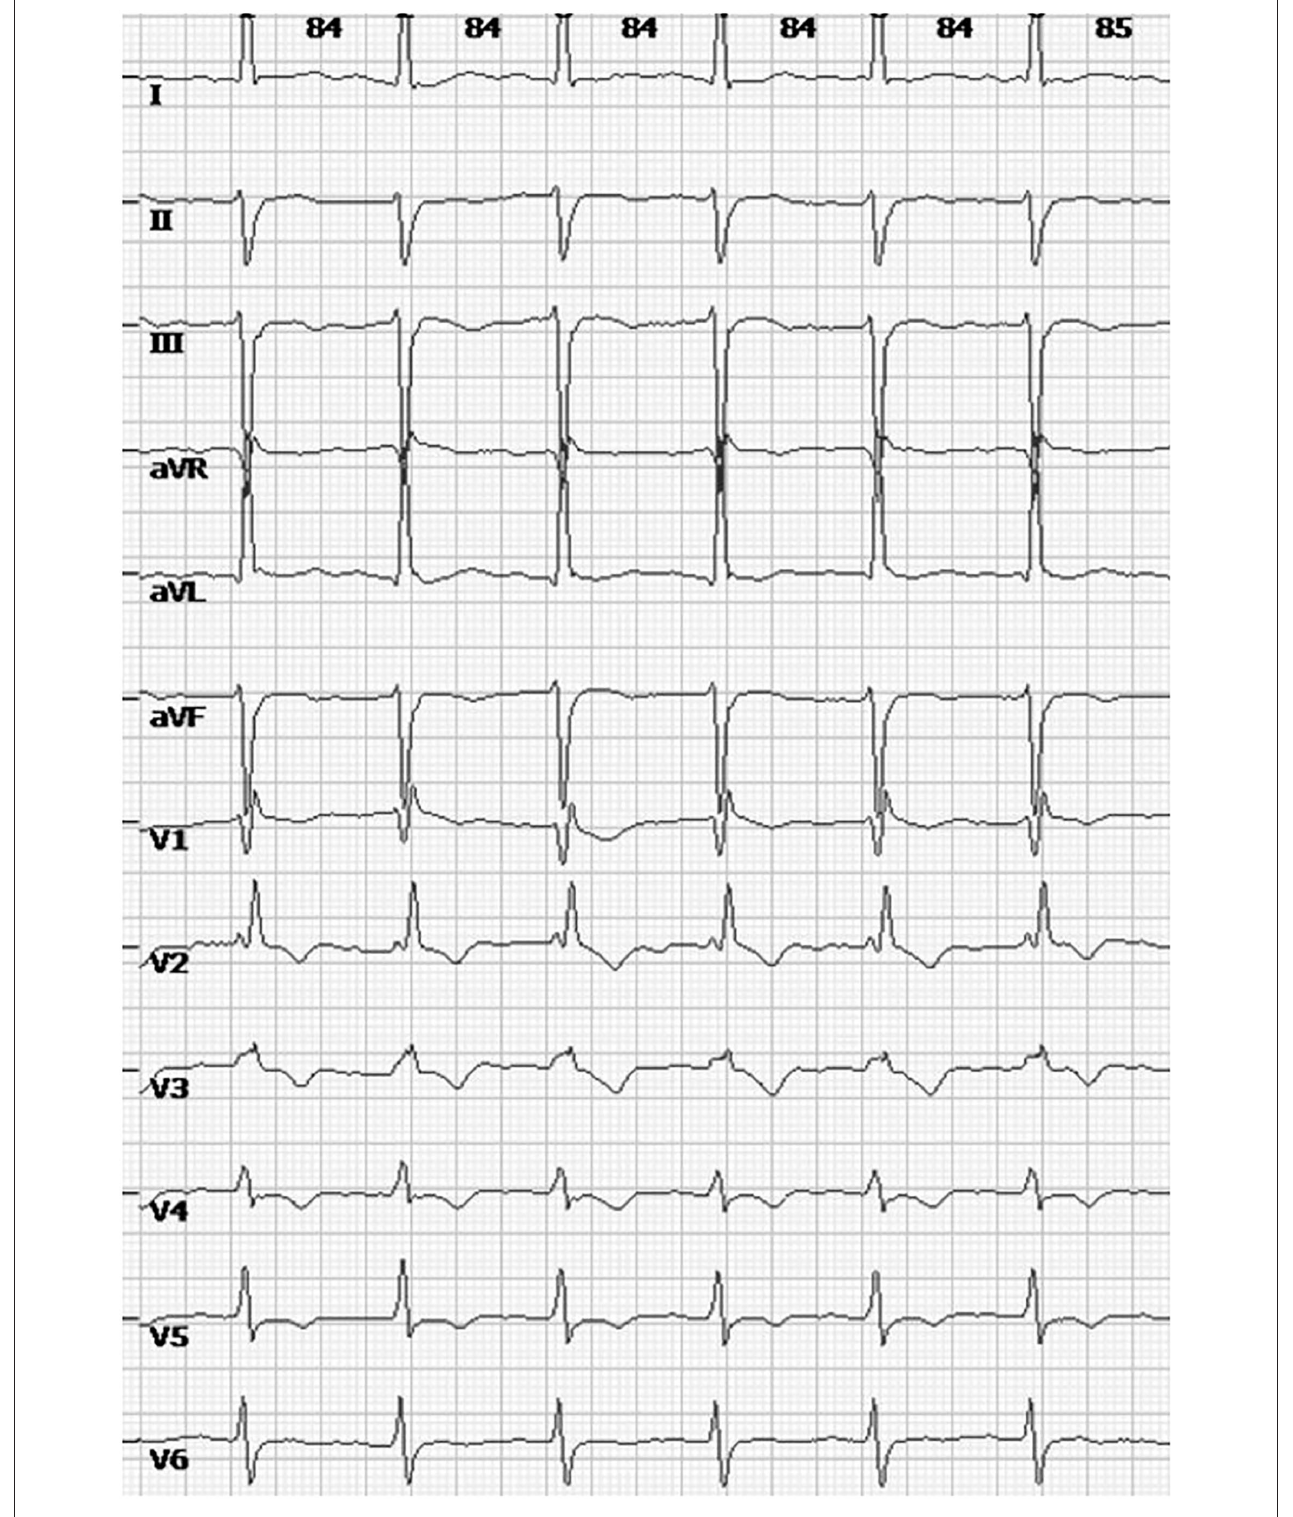
FIGURE 2 | 12-lead ECG showing RBBB and